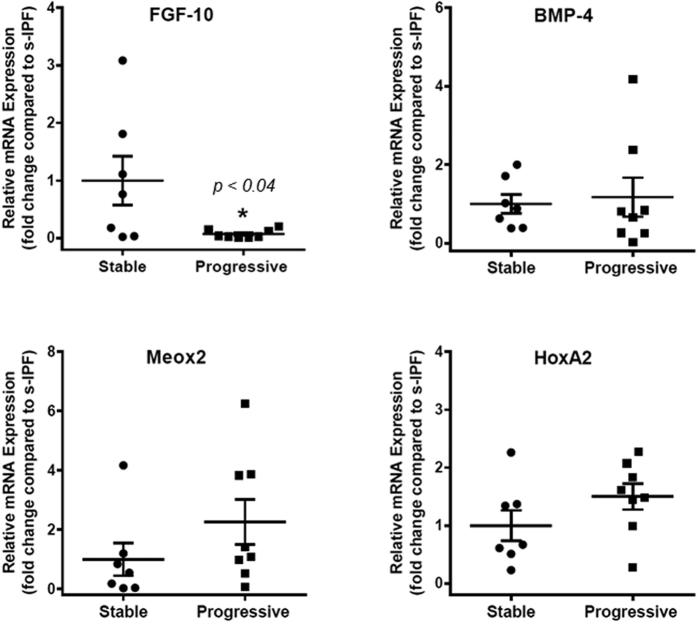
Validation of lung developmental genes of interest.Total RNA was isolated from MSCs from stable IPF (n = 7) and progressive IPF (n = 8), and subjected to real-time PCR analysis for FGF-10, BMP-4, Meox2 and HoxA2. Data were normalized to 18 S rRNA and represented graphically as fold change compared to stable IPF (s-IPF).